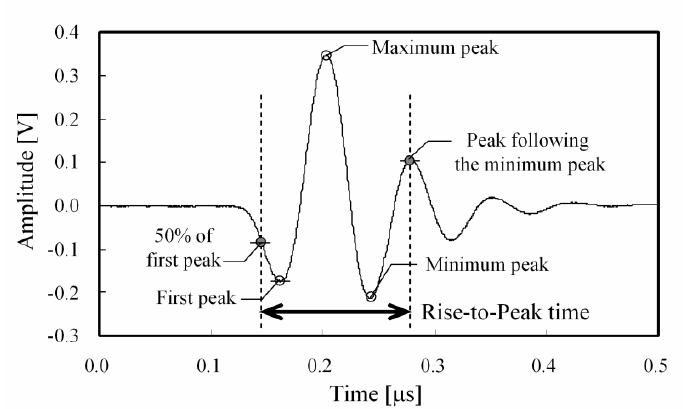
Figure 3: Typical pulse waveform of an ultrasound echo. Center frequency: 10 MHz. Sampling frequency: 1 GHz. The “Rise-to-Peak time” is defined as the time interval between the rise of the first peak (50% amplitude of the first peak) and the first positive peak following the minimum peak of the echo.